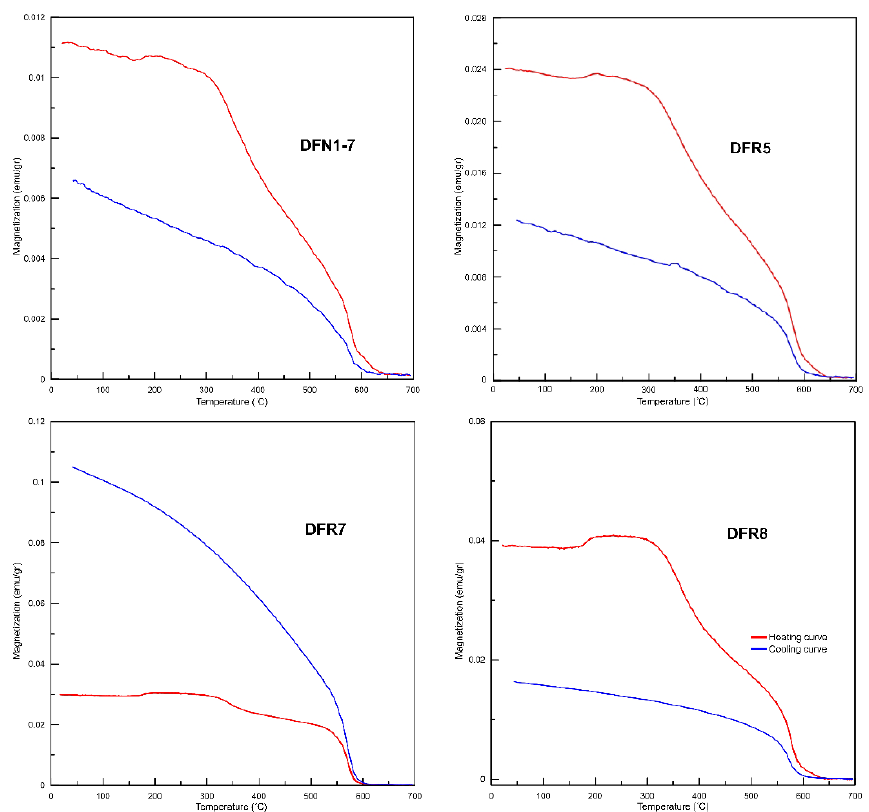
Figure 3. Variation of magnetization with temperature showing the magnetic behavior of representative samples.